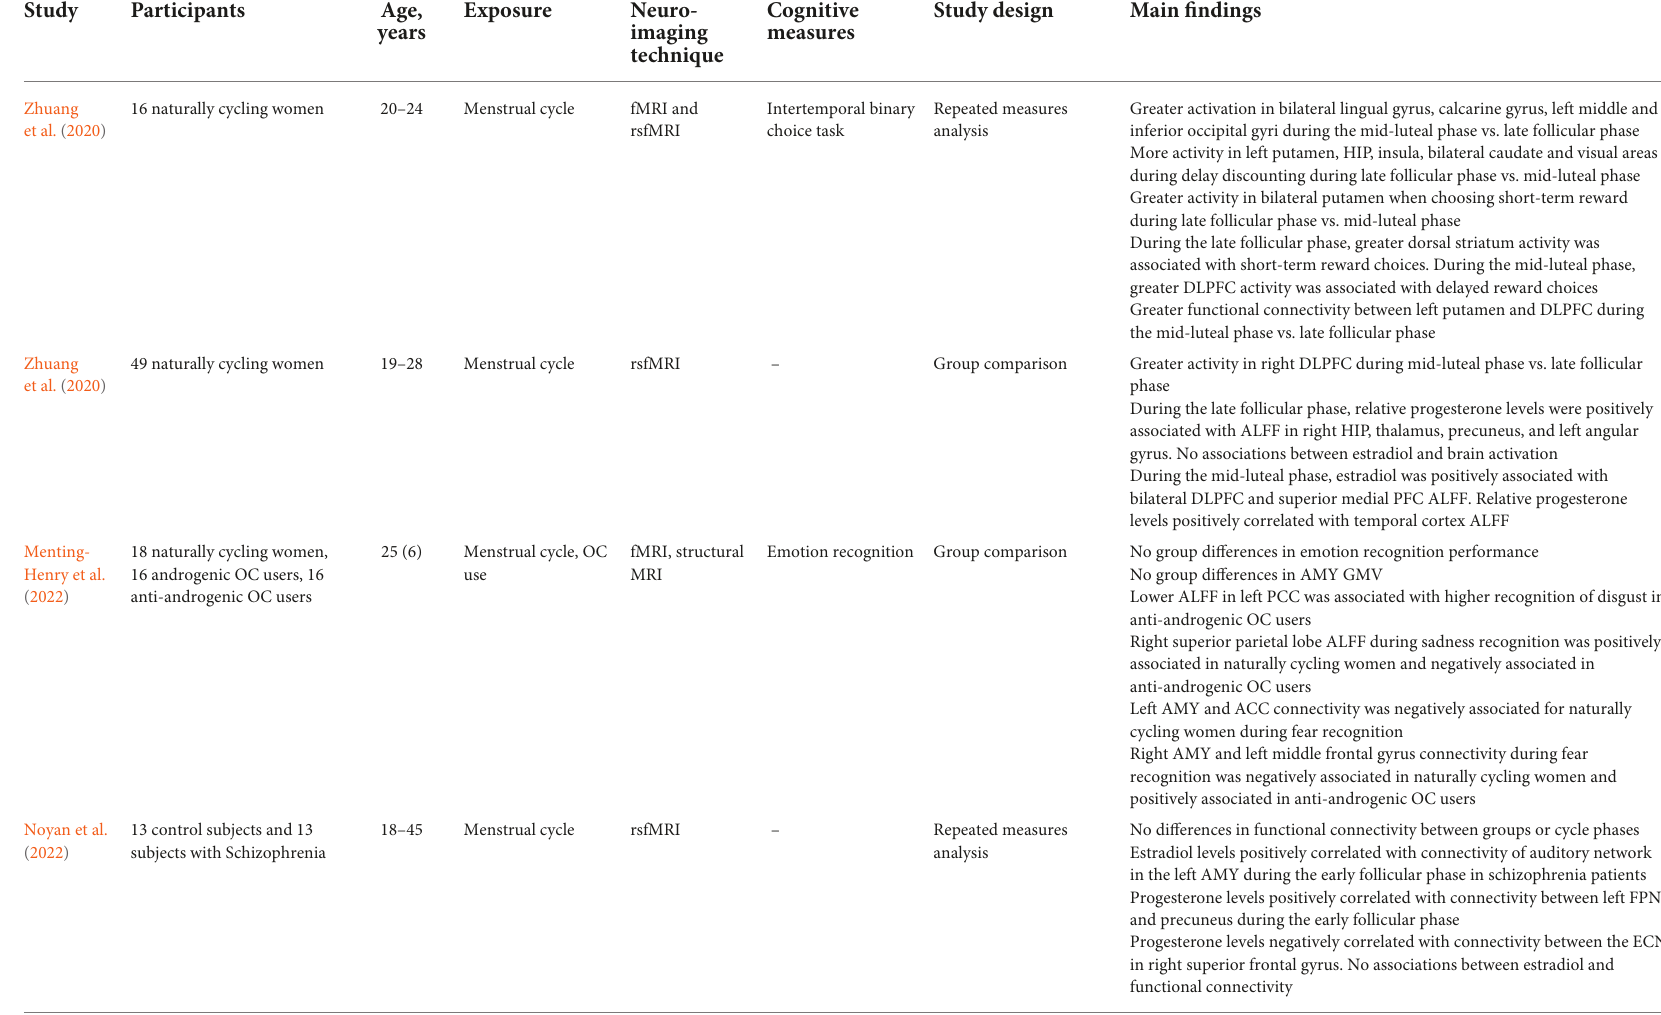
Greater activation in bilateral lingual gyrus, calcarine gyrus, left middle and inferior occipital gyri during the mid-luteal phase vs. late follicular phase More activity in left putamen, HIP, insula, bilateral caudate and visual areas during delay discounting during late follicular phase vs. mid-luteal phase Greater activity in bilateral putamen when choosing short-term reward during late follicular phase vs. mid-luteal phase During the late follicular phase, greater dorsal striatum activity was associated with short-term reward choices. During the mid-luteal phase, greater DLPFC activity was associated with delayed reward choices Greater functional connectivity between left putamen and DLPFC during the mid-luteal phase vs. late follicular phase Group comparison Greater activity in right DLPFC during mid-luteal phase vs. late follicular phase During the late follicular phase, relative progesterone levels were positively associated with ALFF in right HIP, thalamus, precuneus, and left angular gyrus. No associations between estradiol and brain activation During the mid-luteal phase, estradiol was positively associated with bilateral DLPFC and superior medial PFC ALFF. Relative progesterone levels positively correlated with temporal cortex ALFF Emotion recognition Group comparison No group differences in emotion recognition performance No group differences in AMY GMV Lower ALFF in left PCC was associated with higher recognition of disgust in anti-androgenic OC users Right superior parietal lobe ALFF during sadness recognition was positively associated in naturally cycling women and negatively associated in anti-androgenic OC users Left AMY and ACC connectivity was negatively associated for naturally cycling women during fear recognition Right AMY and left middle frontal gyrus connectivity during fear recognition was negatively associated in naturally cycling women and positively associated in anti-androgenic OC users Repeated measures No differences in functional connectivity between groups or cycle phases analysis Estradiol levels positively correlated with connectivity of auditory network in the left AMY during the early follicular phase in schizophrenia patients Progesterone levels positively correlated with connectivity between left FPN and precuneus during the early follicular phase Progesterone levels negatively correlated with connectivity between the ECN in right superior frontal gyrus. No associations between estradiol and functional